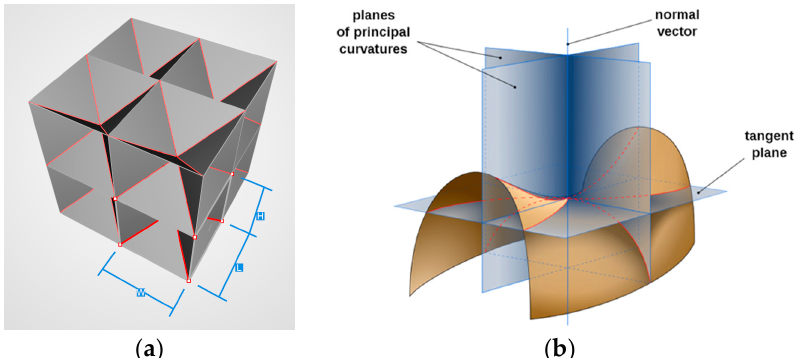
Figure 13. ( a ) Flat surface-based cellular material, screenshot from nTopology’s Element [21], and ( b ) a saddle shaped surface showing minimal surface curvature planes and how a convex and concave curvature result in a mean curvature of zero at every point (Attr: Eric Gaba, Wikimedia Commons).